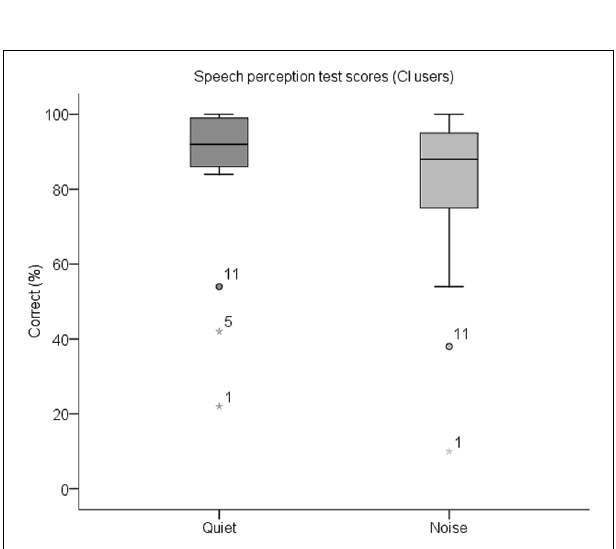
FIGURE 5 | Box plots of speech perception scores in quiet and in noise for CI users. The median score in quiet was 92% correct and in noise was 88% correct. CI participant IDs of outliers are also